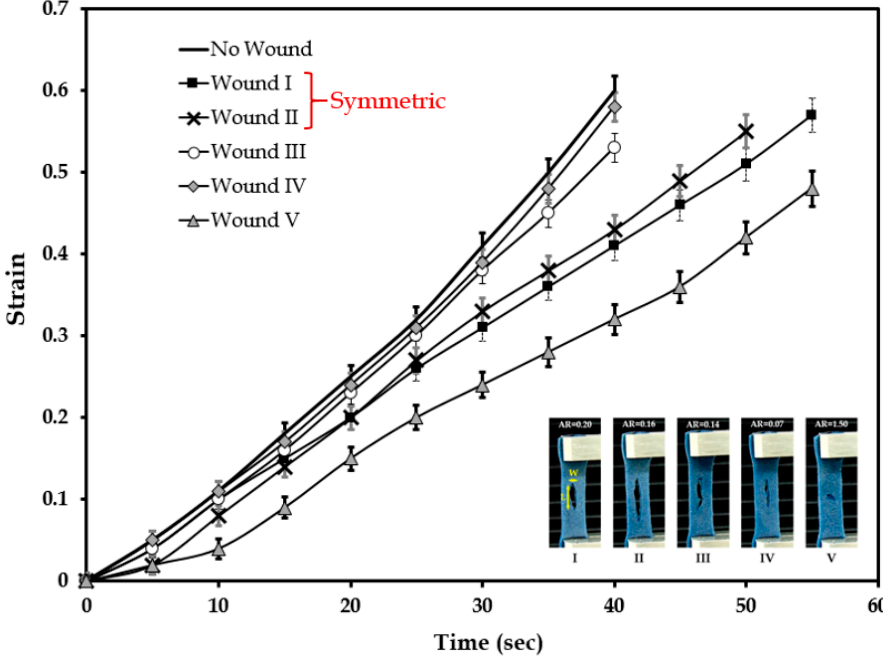
Figure 18. Average strain versus time plots of the specimens with and without